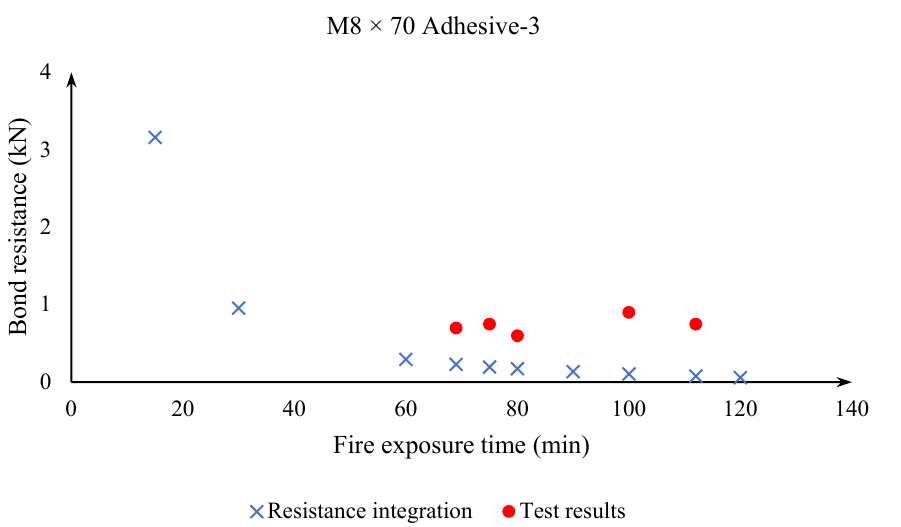
Figure 16. Fire resistance of M8 × 70 bonded anchor using Adhesive-3 after consideration of bond stress beyond T max .